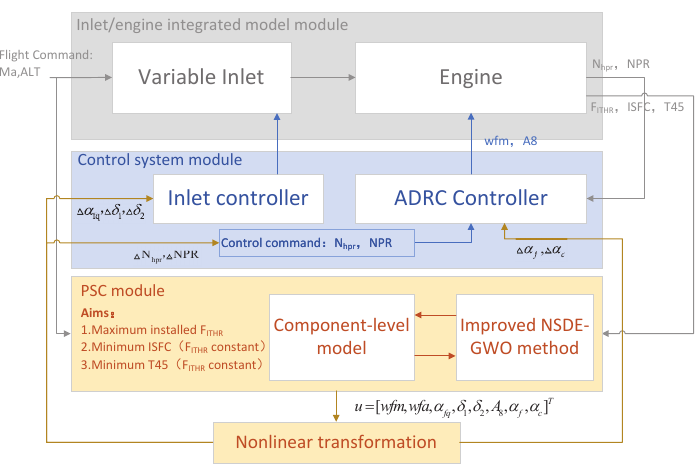
Figure 1. Intelligent optimization and ADRC fusion